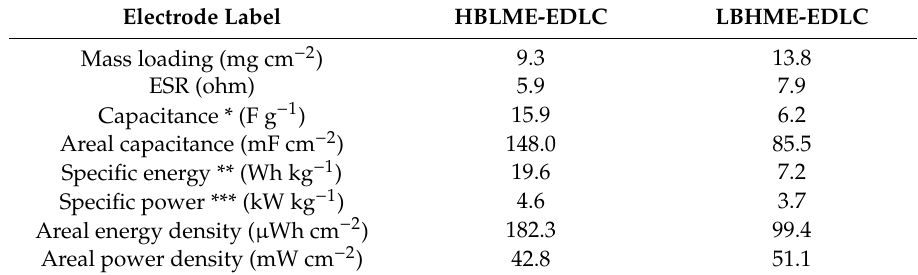
Table 3. Gravimetric and surface quantities of HBLME-EDLC and LBHME-EDLC.